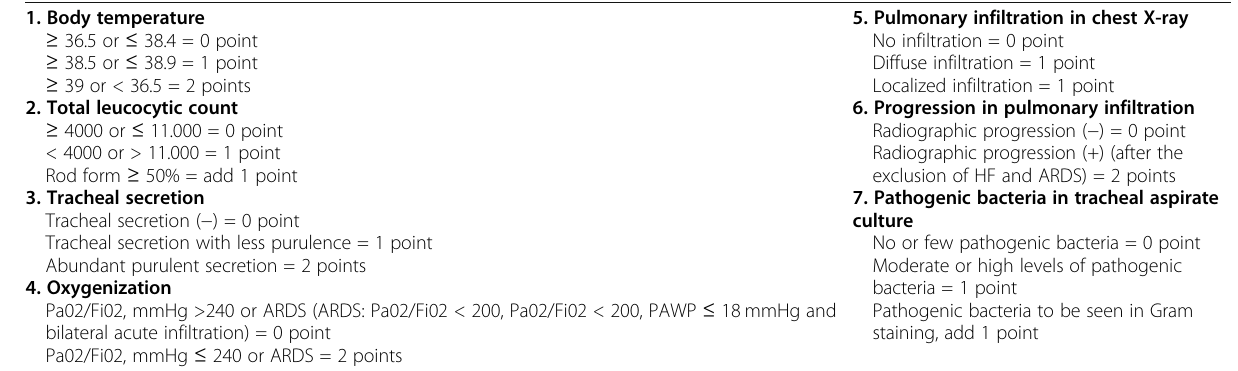
Table 1 CPIS score parameters (Schurink et al.,